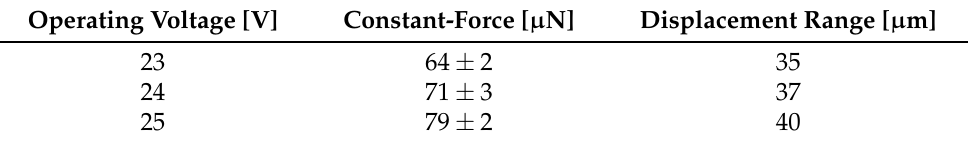
Table 1. Results of the constant-force measurement at different operating